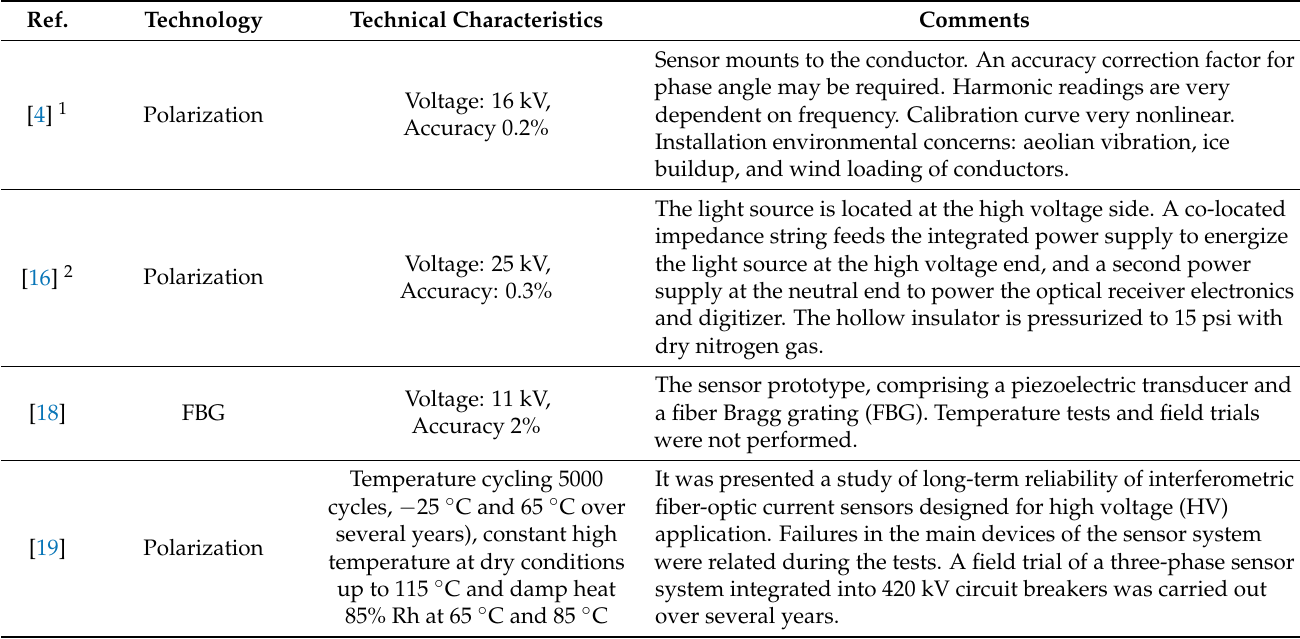
Table 1. Characteristics of optical LPIT described in the